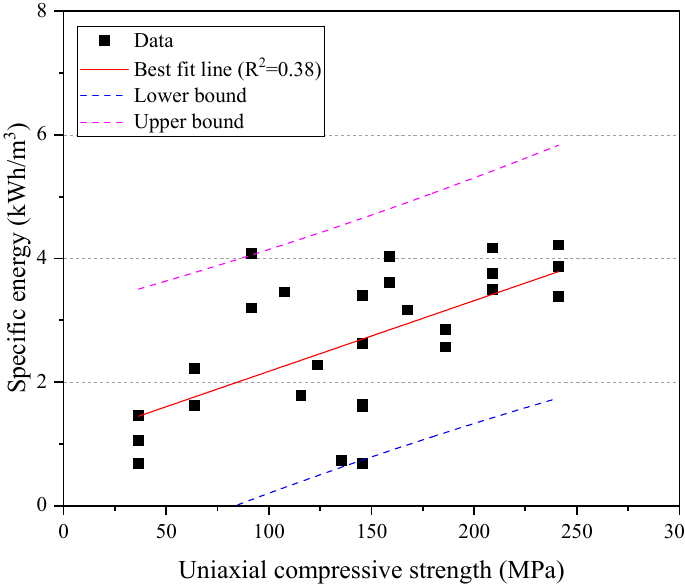
Figure 9. Relationships between UCS and specific energy. Table 6. Prediction models for specific energy under optimum conditions.